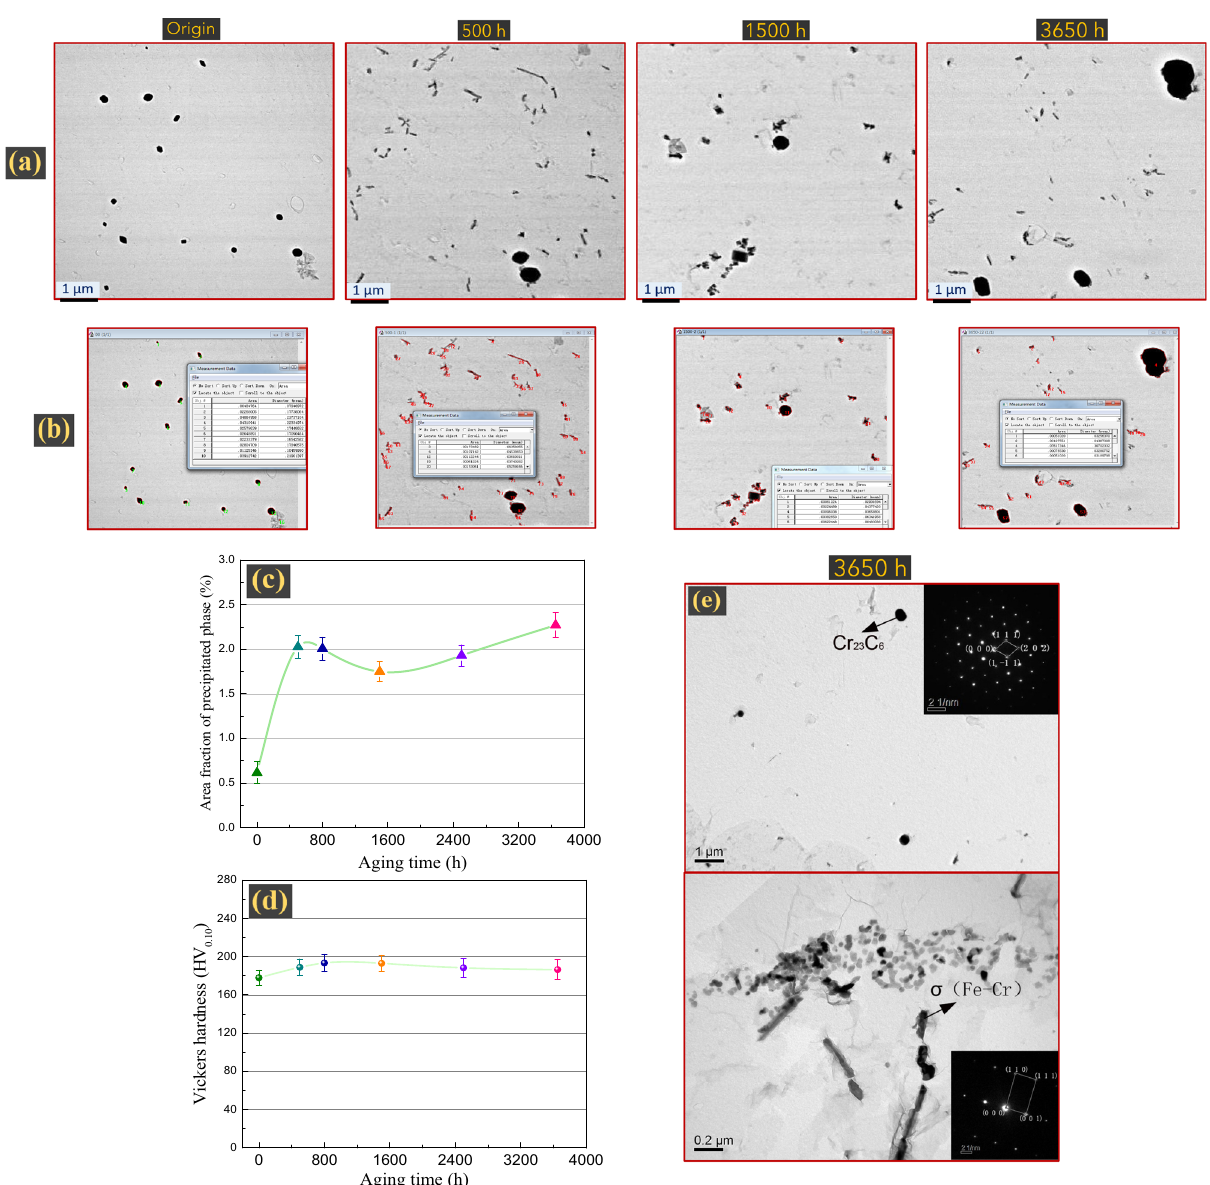
Figure 4: The statistics of area fraction of the precipitates and the hardness measurement of TP347HFG: ( a ) TEM images, ( b ) statistics process and the use of image analysis software, ( c ) the variation of area fraction of precipitates, ( d ) the hardness change in TP347HFG during the aging, and ( e ) the analysis of precipitates by using the SAED